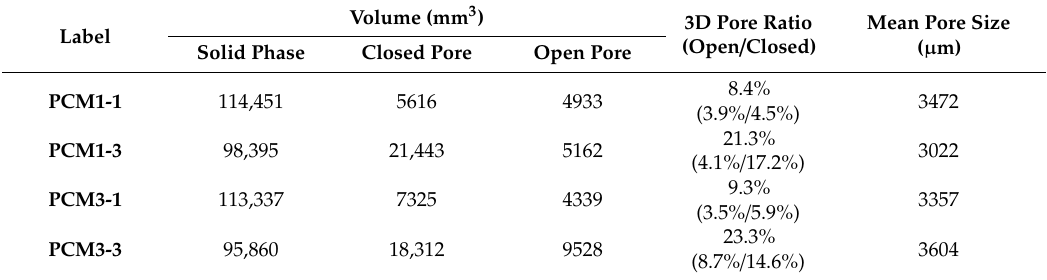
Table 3. X-ray CT-based analysis for the porous structures of PCM1-1, PCM1-3, PCM3-1, and PCM3-3.